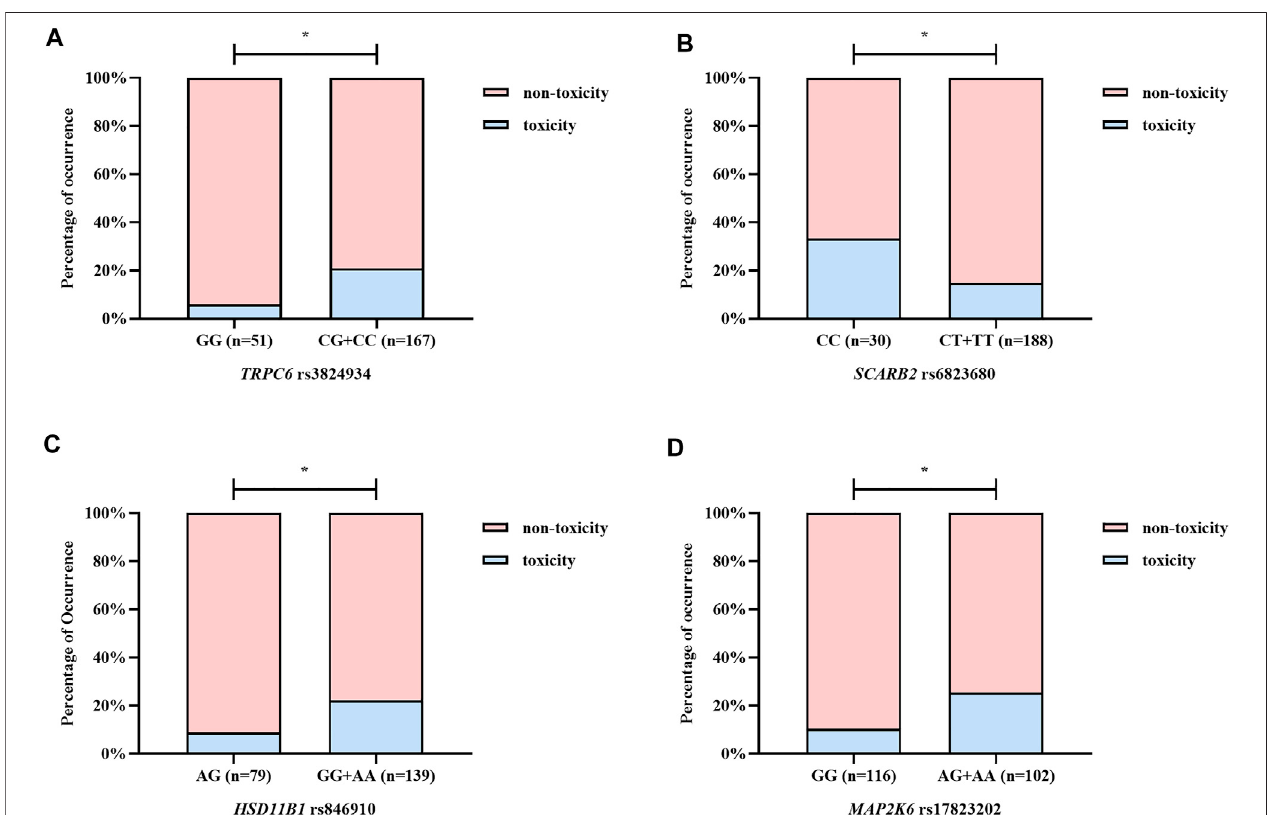
FIGURE3| ThecorrelationbetweentheoptimalvariablesandNAGnephrotoxicity. (A – D) illustrateTRPC6rs3824934,SCARB2rs6823680,HSD11B1rs846910, andMAP2K6rs17823202,respectively.PatientswithTRPC6rs3824934_GG,HSD11B1rs846910 _ AG,andMAP2K6rs17823202_GGgenotypeshavealowerrateof